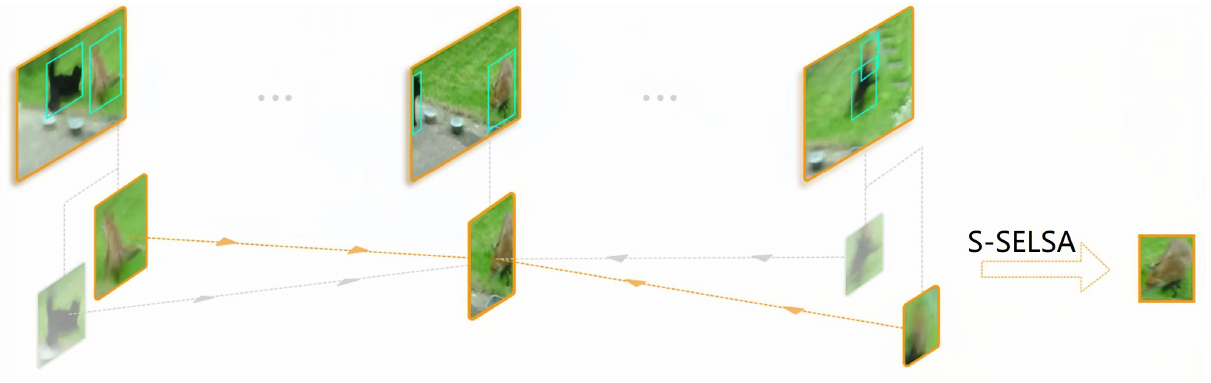
Figure 3. The architecture with S-SELSA. Firstly, some approximate frames are selected from the global perspective through the similarity algorithm proposed in this paper. The module then aggre- gates the features of these